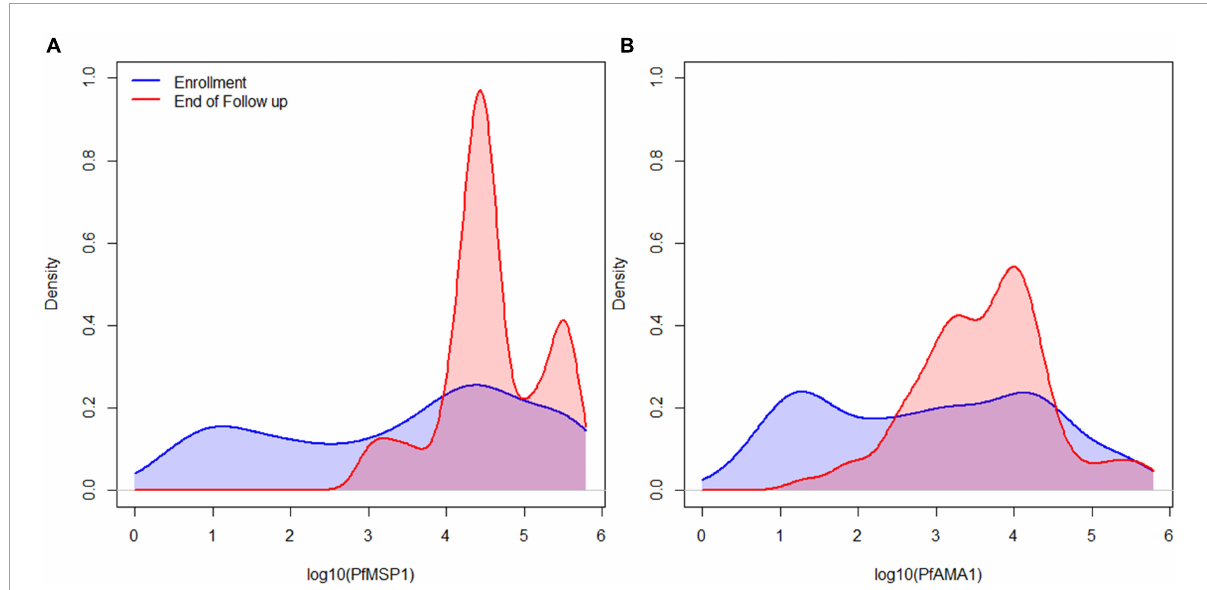
FIGURE1 IgG 1 antibody levels for all participants for the immunogenic P. falciparum PfMSP1 and PfAMA1 antigens. Smoothed distribution of IgG 1 antibody responses to PfMSP1 (A) and PfAMA1 (B) at enrollment (baseline) in blue, and last day of follow-up in red for children treated for P. falciparum